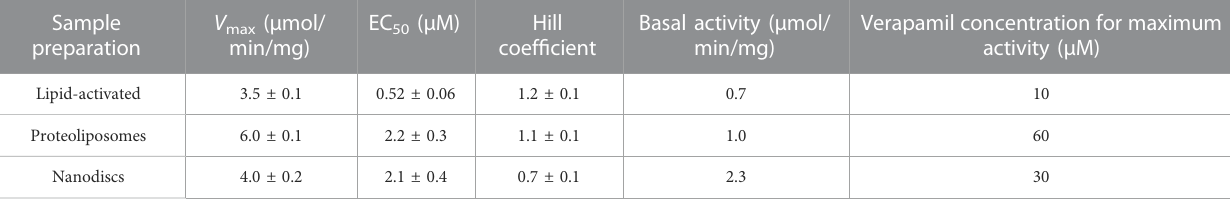
TABLE 7 Pgp was reconstituted intp proteoliposomes and lipid nanodiscs prepared from plasma membrane mimicking lipids, and the verapamil stimulation of ATPase activity was assayed ( n = 3). Sample